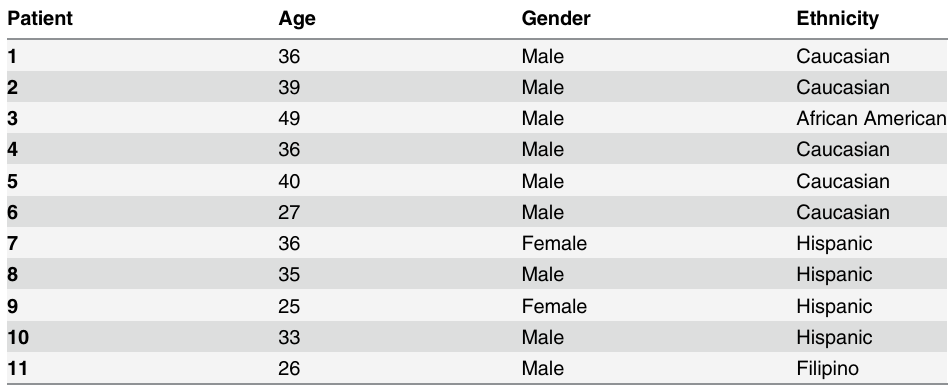
Table 2. Human patient demographic data for samples denoted in Fig.